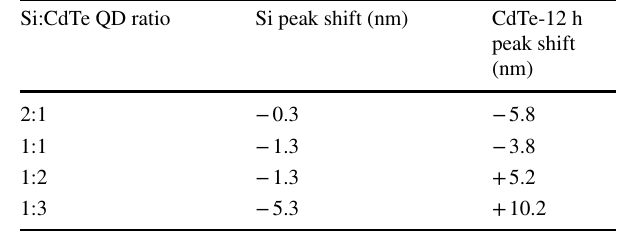
Table 2 Shift observed in the characteristic PL peaks in Si and Table 3 Shift observed in the characteristic PL peaks in Si and